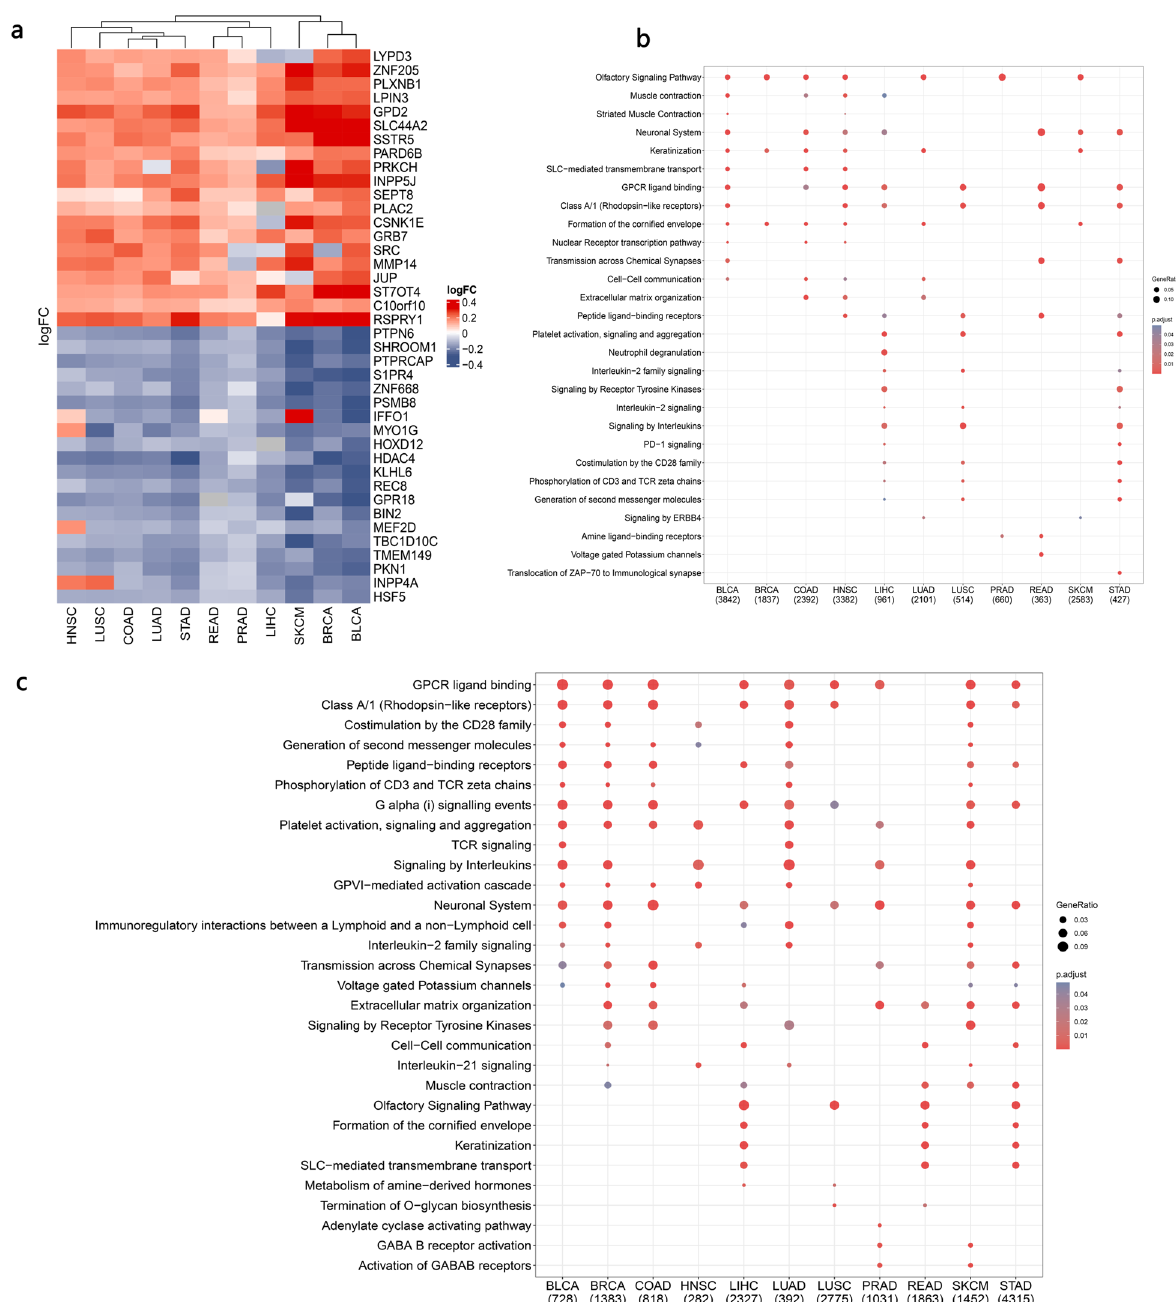
Fig. 5 Reactome pathway analysis of in fl amed/nonin fl amed-speci fi c differently methylated regions. a Heatmap for differently methylated probes. Red represents in fl amed tumor-speci fi c hypermethylated probes and nonin fl amed tumor-speci fi c hypomethylated probes. Gray represents nonin fl amed tumor-speci fi c hypermethylated probes and in fl amed tumor-speci fi c hypomethylated probes. b Enriched reactome pathways for nonin fl amed tumor-speci fi c hypomethylated genes across TCGA tumor types. c Enriched reactome pathways for in fl amed tumor-speci fi c hypomethylated genes across TCGA tumor types. The number (below b and c ) refers to the number of dysregulated genes (up or down) in each tumor